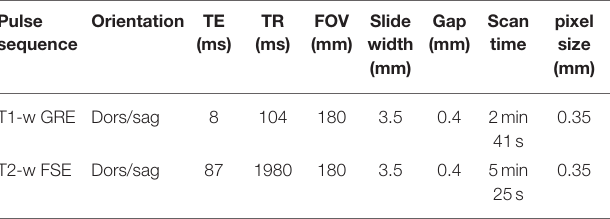
TABLE 1 | High resolution (HR) pulse sequences parameters using low-field open (0.27T) MRI system 1 . Pulse Orientation TE sequence